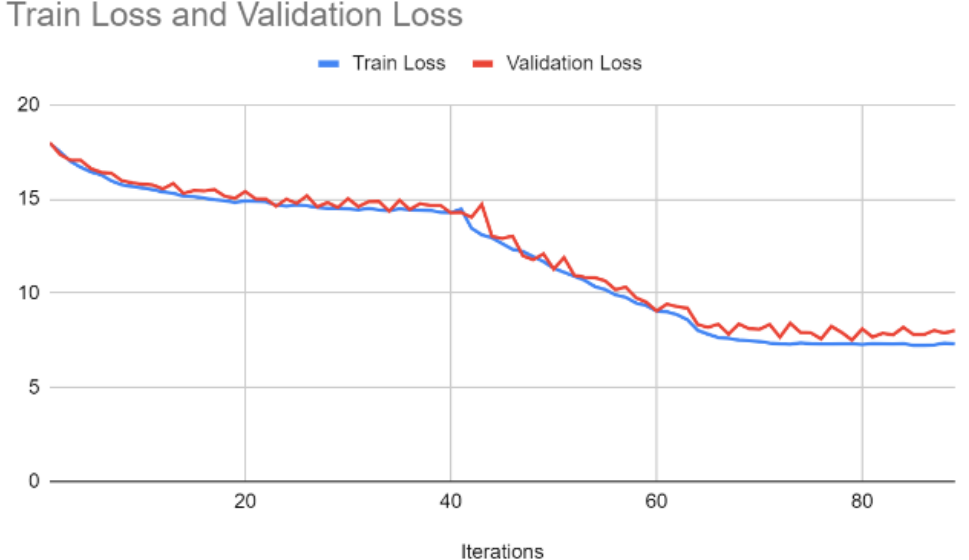
Figure 15. Loss Graph for YOLO